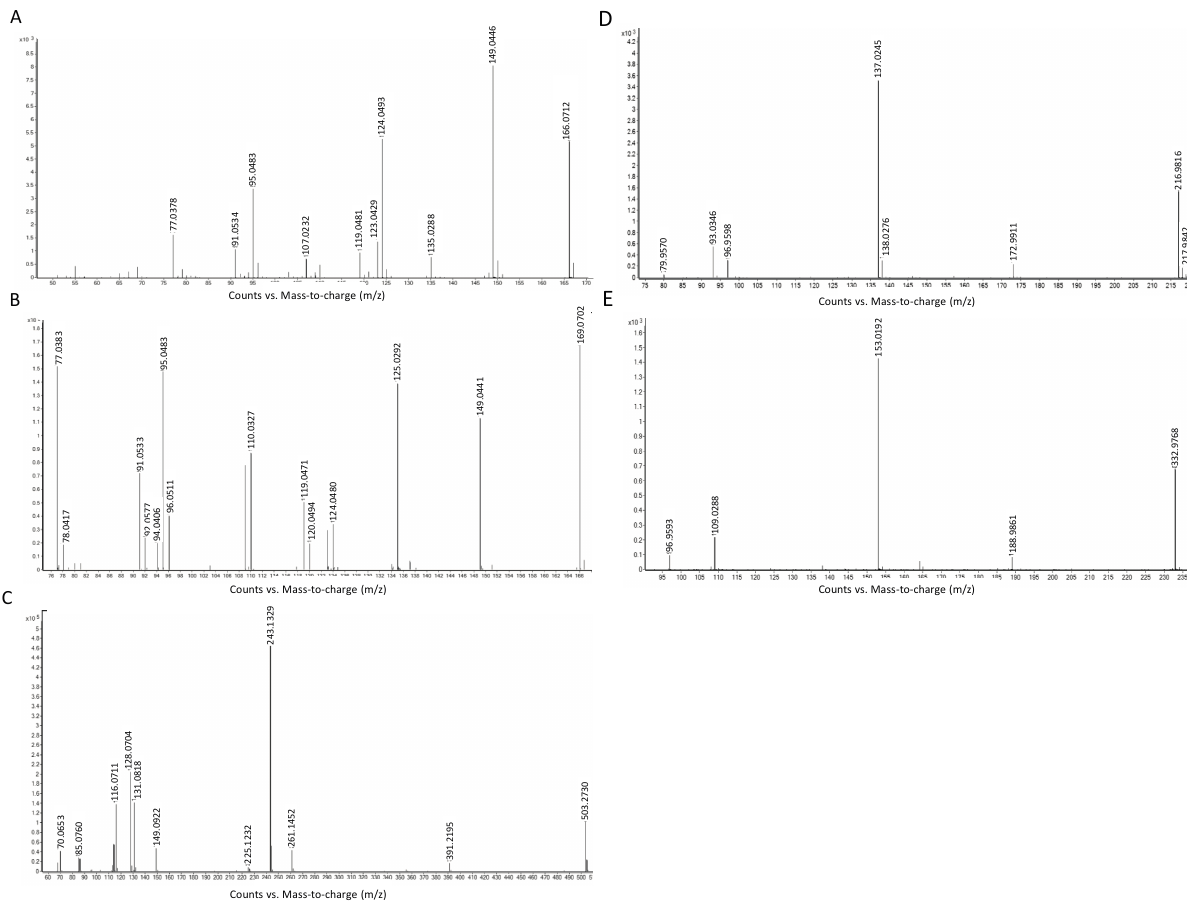
Figure 5. MS/MS spectra of ( A ) 7-methylguanine; ( B ) 1-methylguanine; ( C )